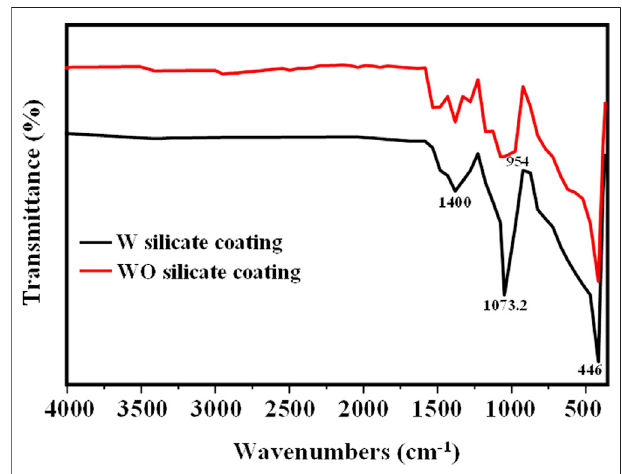
FIGURE 6 | Infrared absorption spectroscopy (FT-IR) of WO and W silicate coating